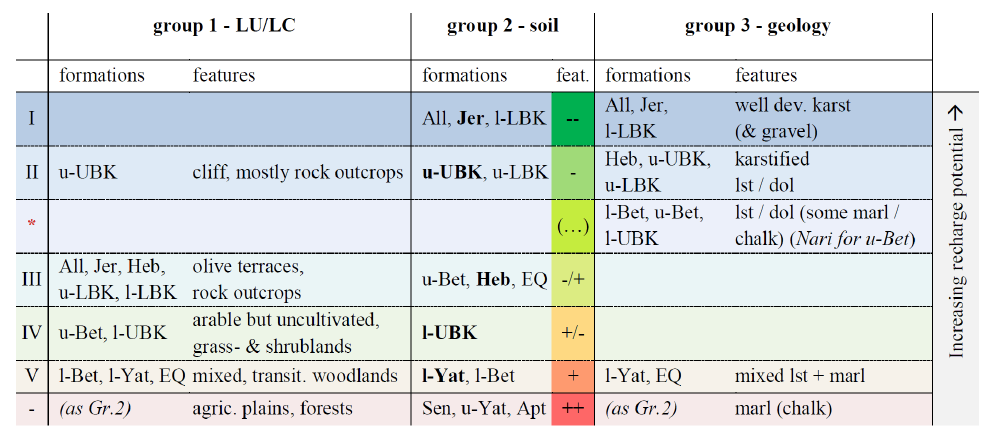
Table 3. Conceptual basin classification framework, specific to Wadi Natuf.